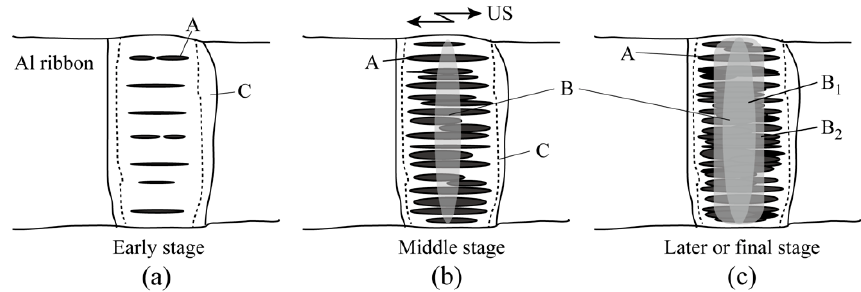
Figure 12. Schematic illustrations of interfacial bonding process between Al ribbon and silica substrate, which are observed from silica side; ( a ) Early stage after large sliding; ( b ) Middle stage in which island streaks increase and central belt zone B forms; ( c ) Later or final stage in which B 2 appears around B 1 . B 2 is behind B 1 .